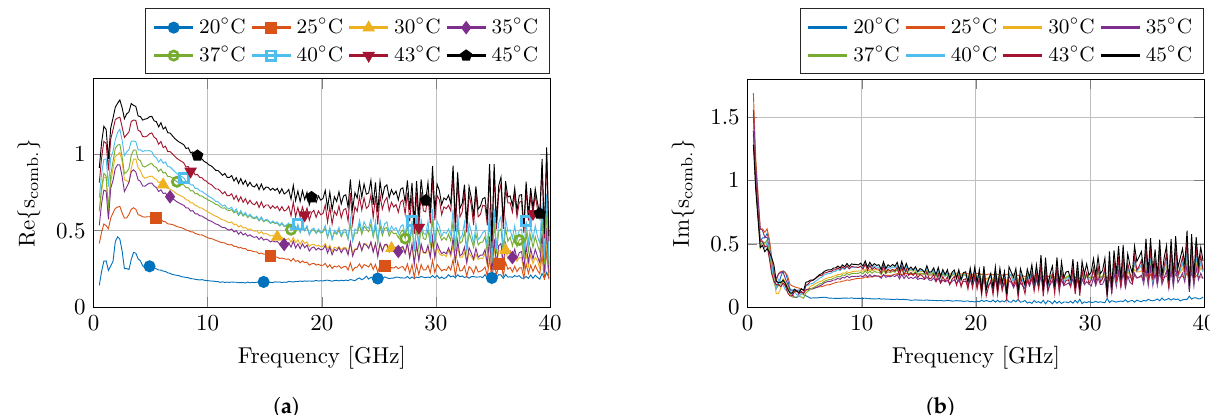
Figure 4. The calculated combined complex uncertainty s comb. for each set of measurements at the corresponding tempera- ture step. The real and imaginary part are displayed in ( a , b ),